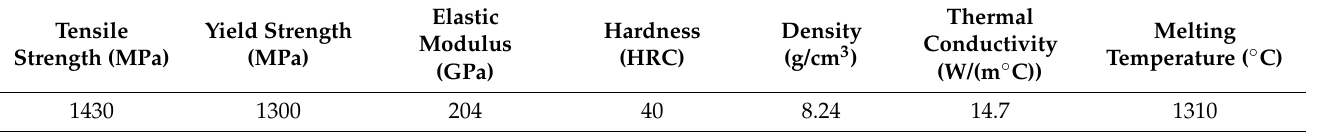
Table 2. Physical properties of Inconel